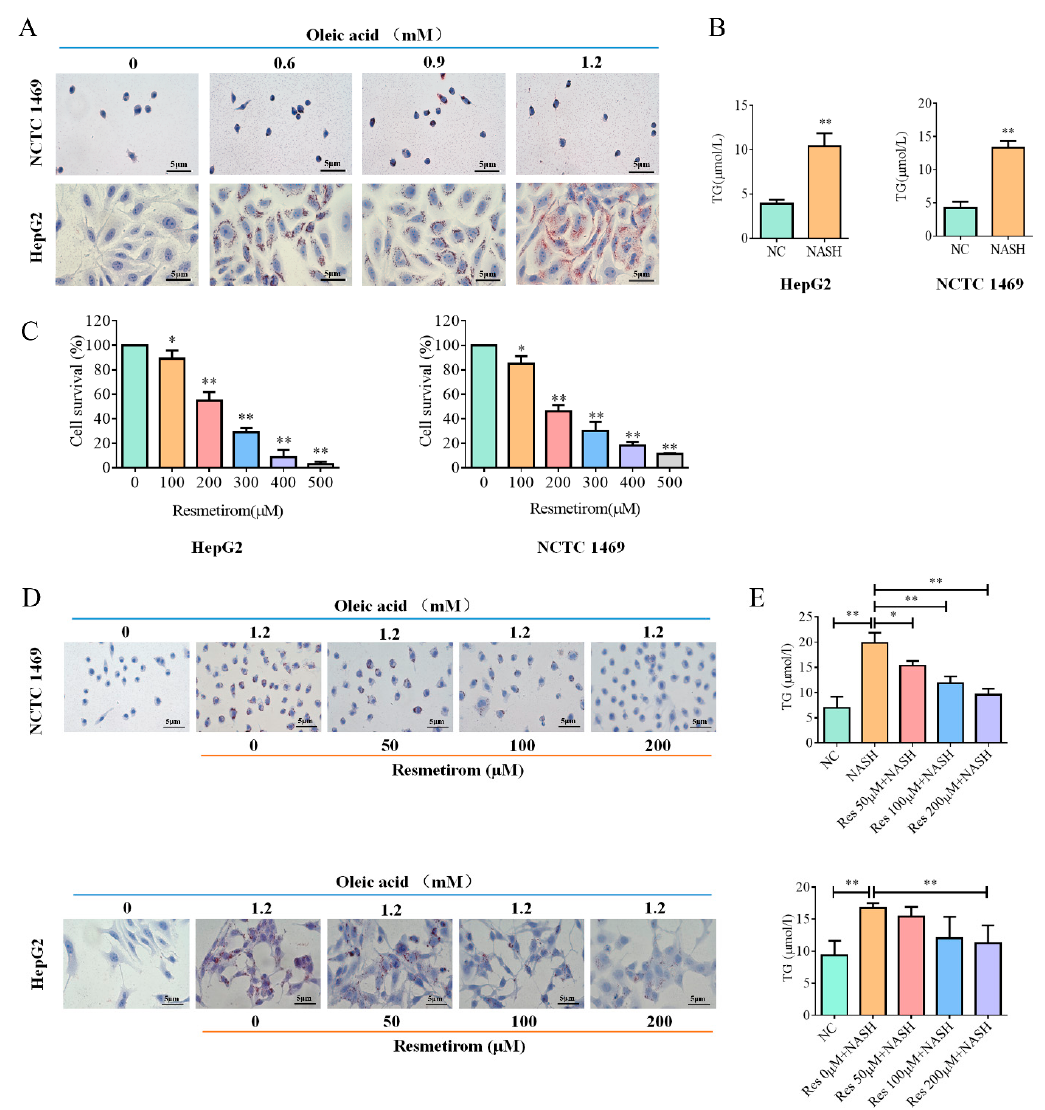
Figure 1. Resmetirom effectively improved NASH in cell models generated using oleic acid. ( A ),